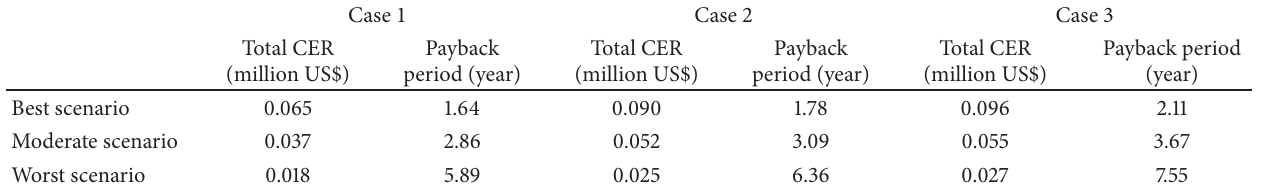
Table 7: Total annual CER and payback period for guarantee value for each scenario of CER unit